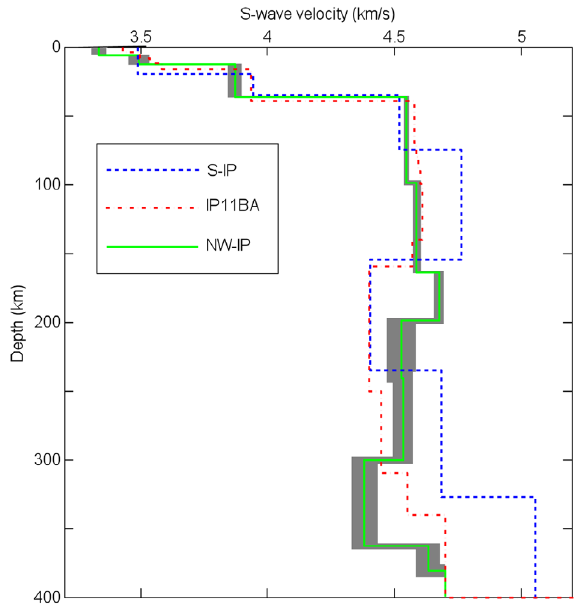
Figure 10. The upper mantle S -wave velocity ( Vs ) structure of NW- IP (present study) compared with those of south Indian Peninsula (S-IP, Mitra et al. [2006]) and Bastar craton in east Indian Peninsula (IP11BA, Bhattacharya et al. [2009]). The grey area around the NW- IP model shows its standard deviations in